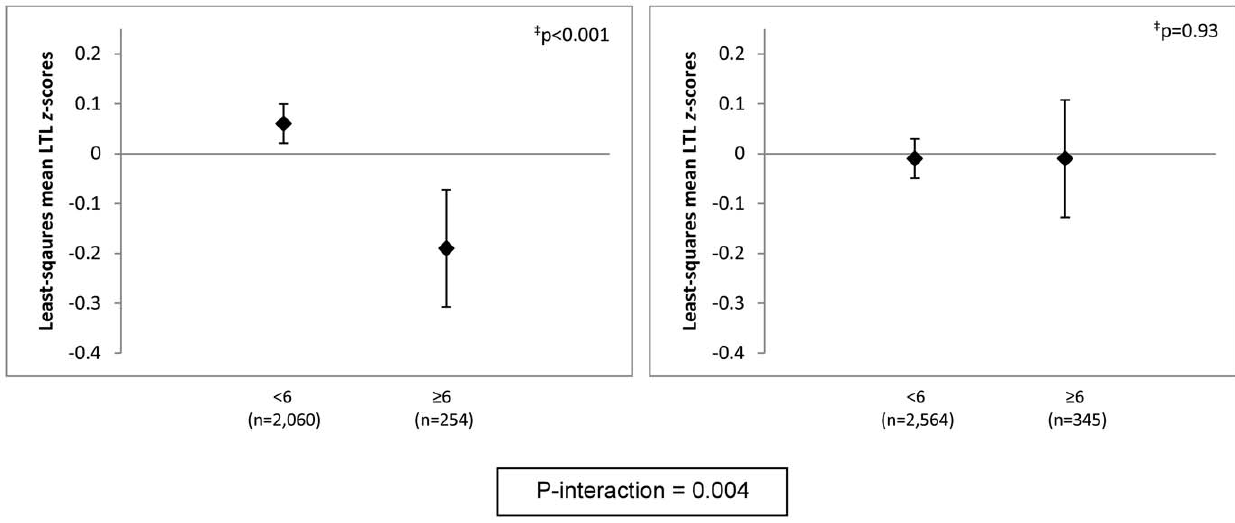
Figure 2. Adjusted* least-squares mean telomere length z -scores, by phobic anxiety level, stratified by smoking status (never or current/past). *, Models were adjusted for age in years (continuous), paternal age-at-birth (15–24, 25–29, 30–34, 35–39, $ 40 years), body mass index (continuous, kg/m 2 ) and physical activity (continuous, MET-hrs/wk). Least squares means and 95% confidence intervals are shown. N=20 excluded due to missing smoking status. { , P-value for test of difference in least-squares means.